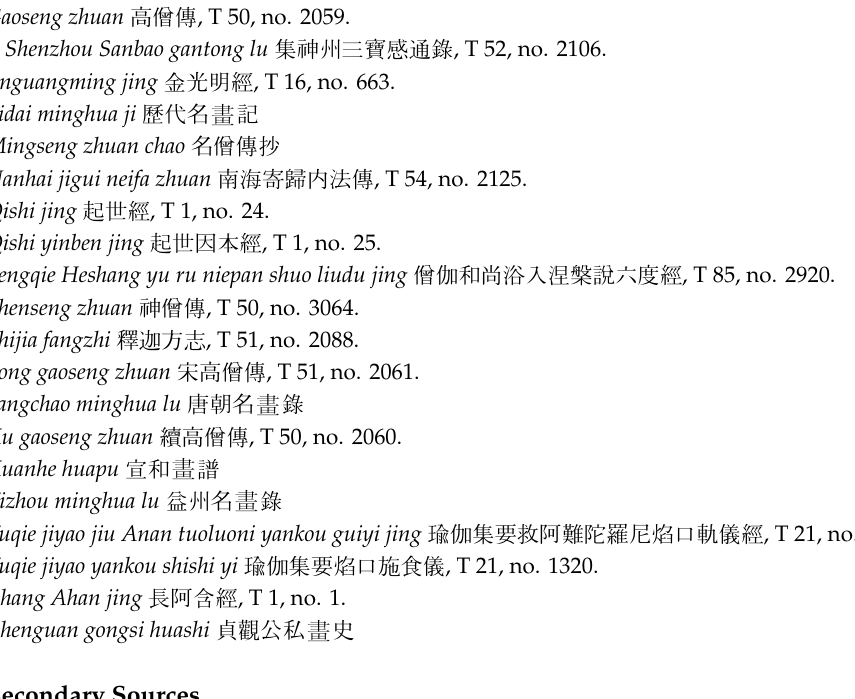
Figure 7. Itinerant Monk . Dunhuang, 10th century. Ink and colors on paper, 51.8 × 29. 3 cm. Inv. No.